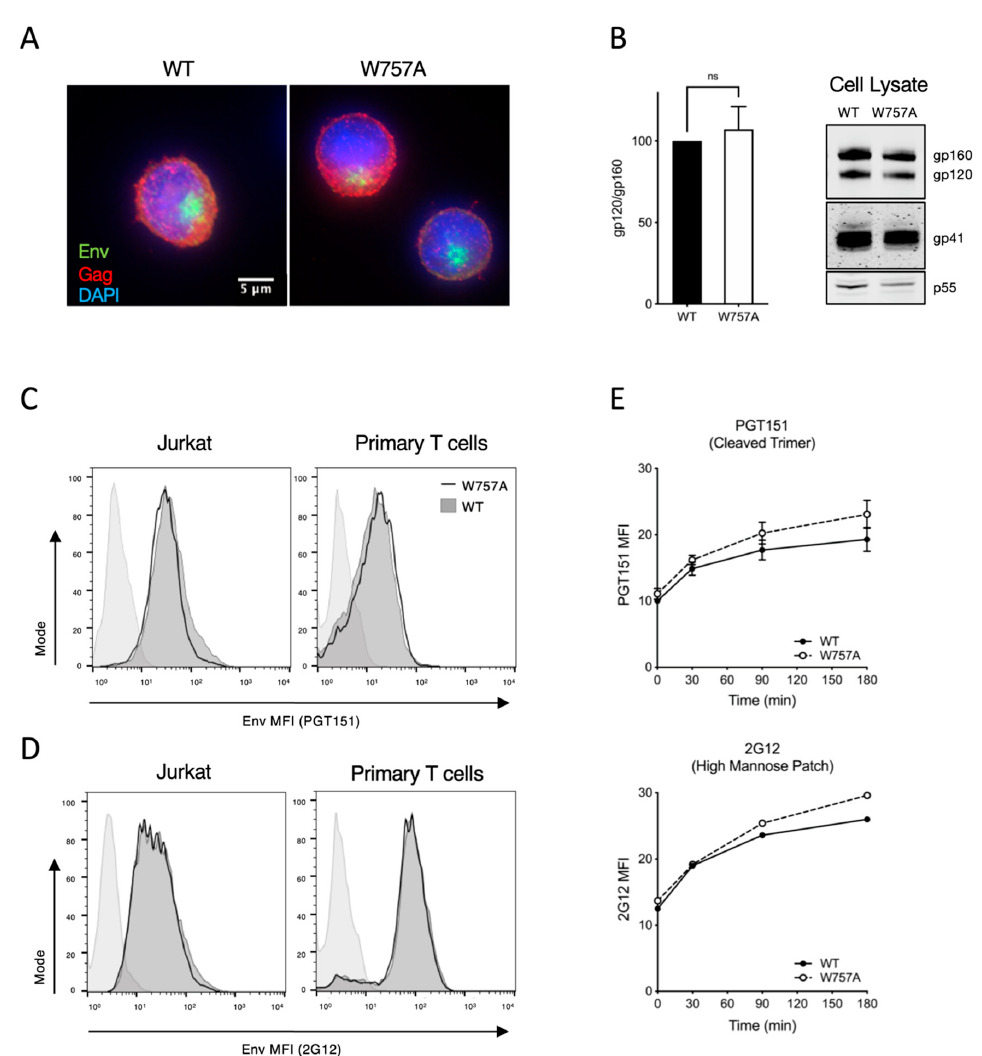
Figure 5. Synthesis, processing and recycling of EnvCT W757A is equivalent to that of WT EnvCT. ( A ) Intracellular immunofluorescence staining of Env (green) and Gag (red) in Jurkat cells infected with WT and W757A at 48 hpi. ( B ) Western blot of infected Jurkat cell lysates harvested 48 hpi and probed with anti-gp120, anti-gp41 and anti-Gag p55/p24. Quantification of Env processing (gp120/gp160). Data show the mean and SEM from at least three independent experiments compared using a two-tailed paired t -test (ns, not significant). ( C ) Flow cytometry analysis of cell surface Env levels on cells infected with WT (dark grey, filled) and W757A (solid black line, unfilled) virus measured using bNAb PGT151. Uninfected control is shown as light grey-filled histogram. ( D ) Flow cytometry analysis of cell surface Env levels on cells infected with WT (dark grey, filled) and W757A (solid black line, unfilled) virus measured using 2G12 as in ( C ). ( E ) Time course of endocytosed Env recycling back to the plasma membrane measured by flow cytometry. Env was stained with either PGT151 or 2G12. Envelope recycling was measured by staining with envelope antibody and a PE ‐ secondary on ice followed by Cy5 at 37 °C. Recycling is shown as the MFI of PE + CY5 + signal on the surface over time. Data show the mean and SEM from three independent experiments.